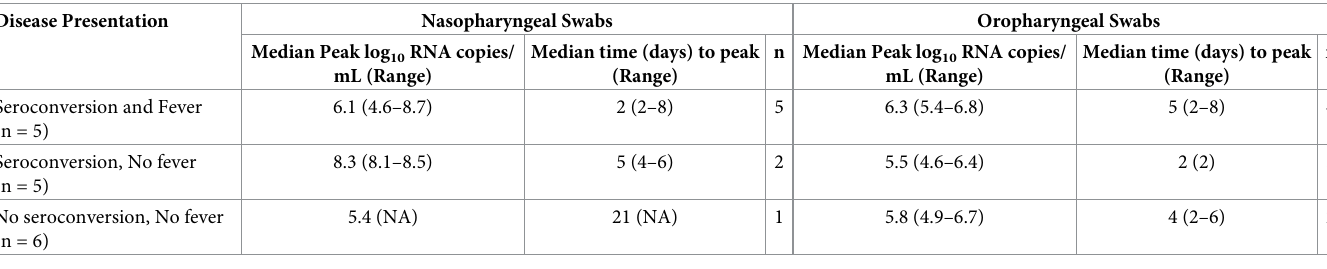
Table 3. Summary of viral RNA shedding in oropharyngeal and nasopharyngeal swabs. Disease